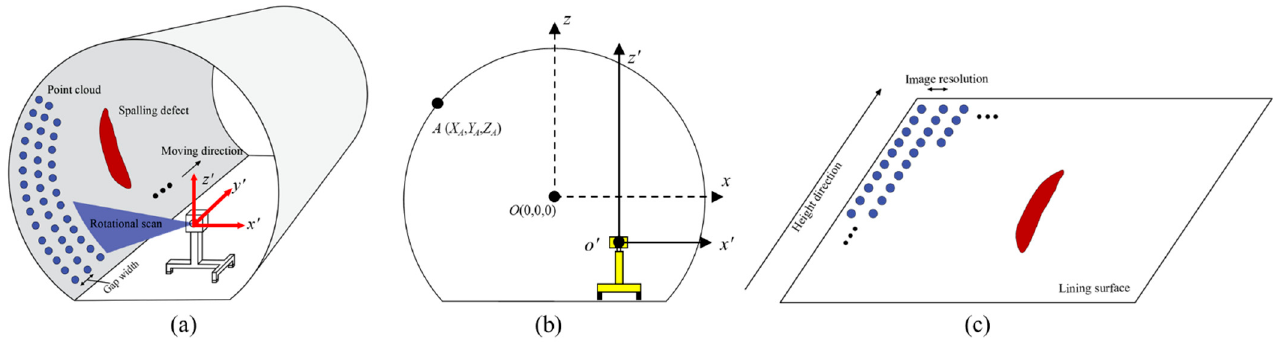
Figure 2. Laser scanning data acquisition: ( a ) point cloud data of the tunnel lining, ( b ) experiment location, ( c ) the MLS system.